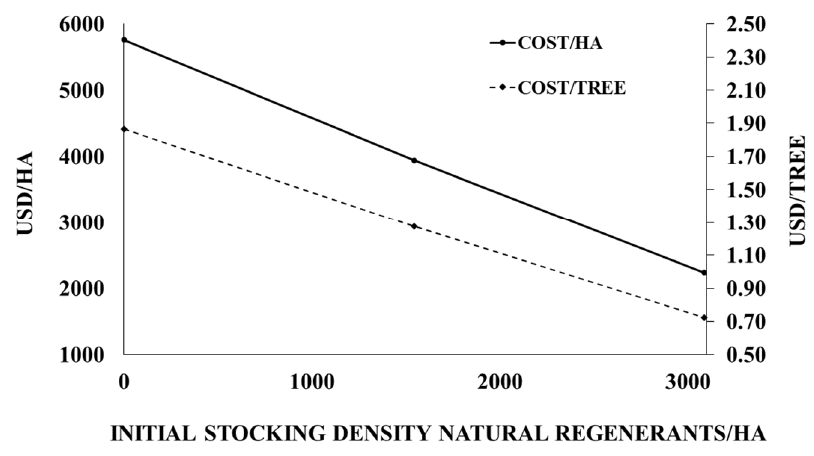
Figure 3. Forest restoration costs decline with increasing density of pre-existing natural regenerants (assuming 10 ha restored) (includes field costs, interest on loans, and 10% contingency for unanticipated transaction costs) (data from FORRU-CMU, August 2021).